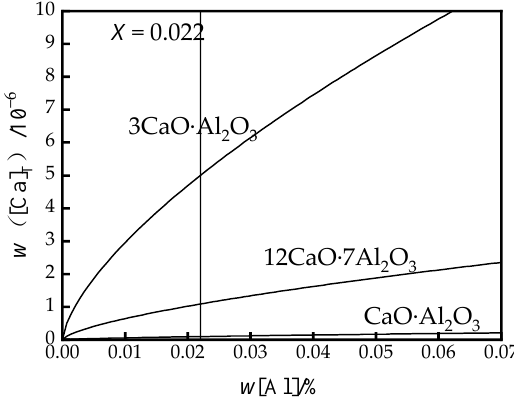
Figure 9. Al-Ca equilibrium curve.